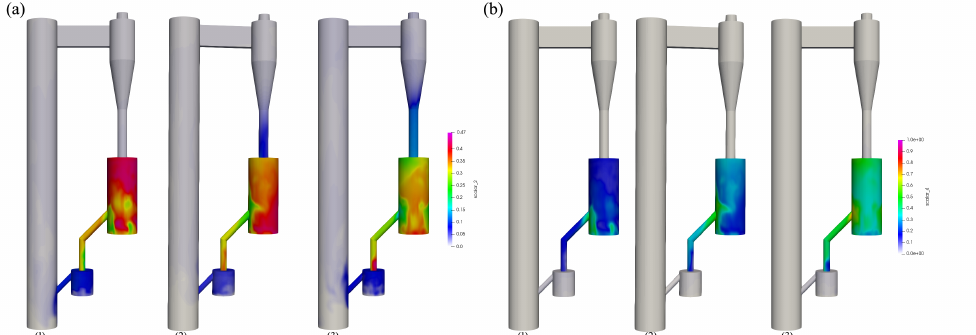
Figure 8. Time-averaged gaseous mass fraction at the outlet of fuel reactor. The solid inventory is 34.6 kg.